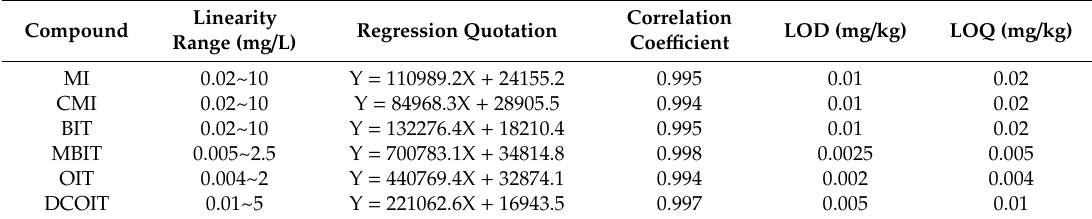
Table 1. Calibration curves, limit of detection (LOD) and limit of quantitation (LOQ) for 6 isothiazolinones in the water-based adhesive. Linearity Compound Range (mg / L)